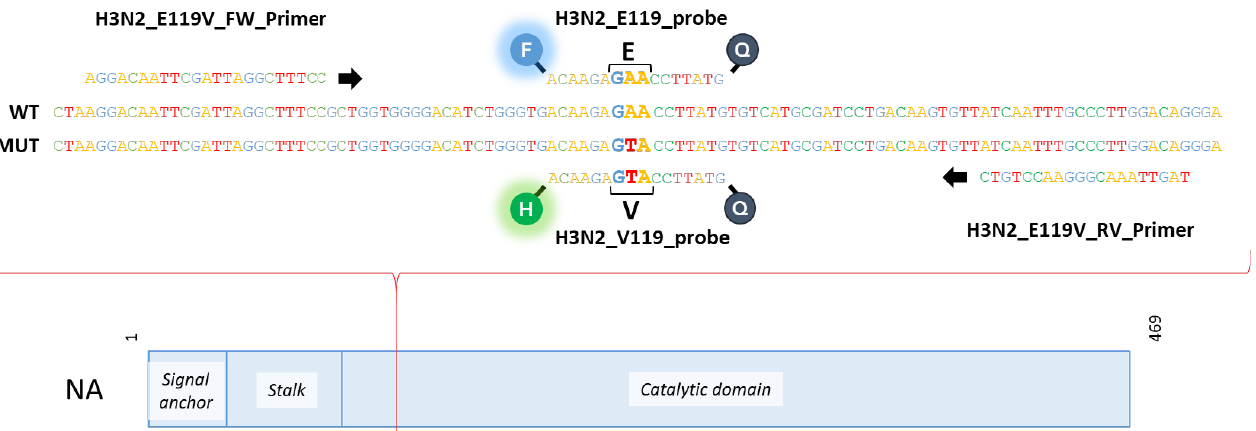
Figure 1. Visualisation of NA segment with the position of the E119V mutation that is linked to antiviral resistance in A(H3N2) influenza viruses . NA contains three major functional domains, namely the signal anchor that contains the transmembrane domain, and the stalk domain and catalytic domain [39]. The stalk domain is believed to position NA in respect to its receptor and the length varies within and across NA subtypes [40–46]. The catalytic domain is responsible for the viral release and it removes the cell surface receptor to prevent interparticle aggregation [47–52]. This contributes to the assembly process by tethering the stalk to the membrane in a tetrameric conformation. The modification introduced by reverse genetics allows a substitution of a glutamate-to-valine mutation in NA at residue 119 (red line). Therefore, the NA with E119V may accommodate a water molecule, which would interfere with the binding of oseltamivir to the active site. Moreover, the E119V mutation affected the optimal orientation of oseltamivir within the active site and also affected its overall conformation [11,53]. The primers and probes bind with the sequence and the two probes will allow the discrimination between glutamate (E, FAM in blue) and valine (V, HEX in green) at position 119.